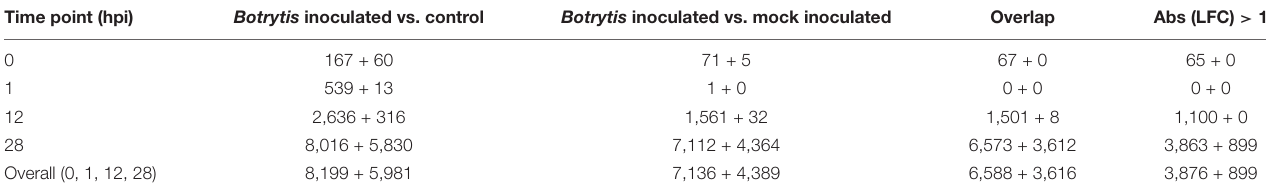
TABLE 2 | Differential expression analysis using DESeq2 in R. Time point (hpi) Botrytis inoculated vs. control Botrytis inoculated vs. mock